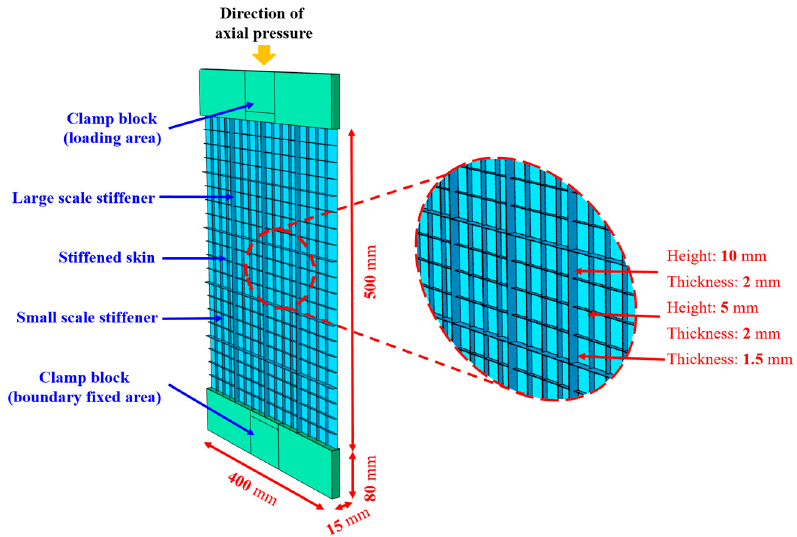
Figure 3. Geometric model of the hierarchical stiffened plate.